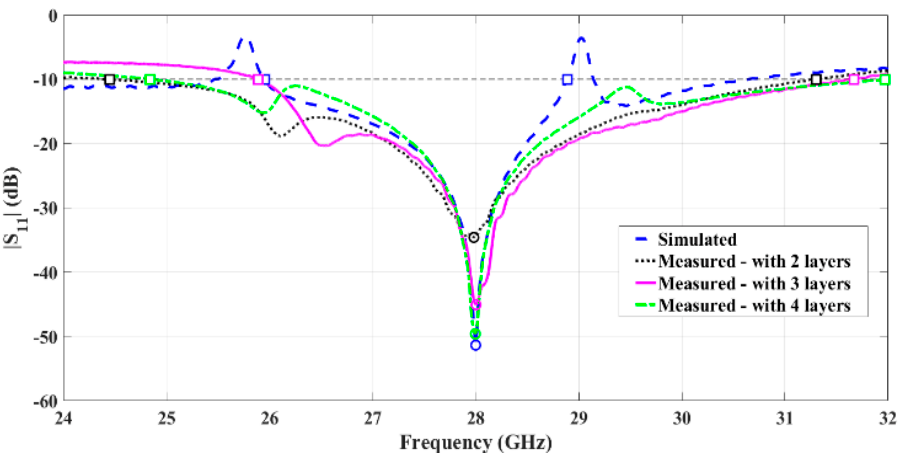
Figure 8. Comparison between simulated and measured reflection coefficient of the fabricated horn antennas using conductive paint, with different numbers of ink layers.